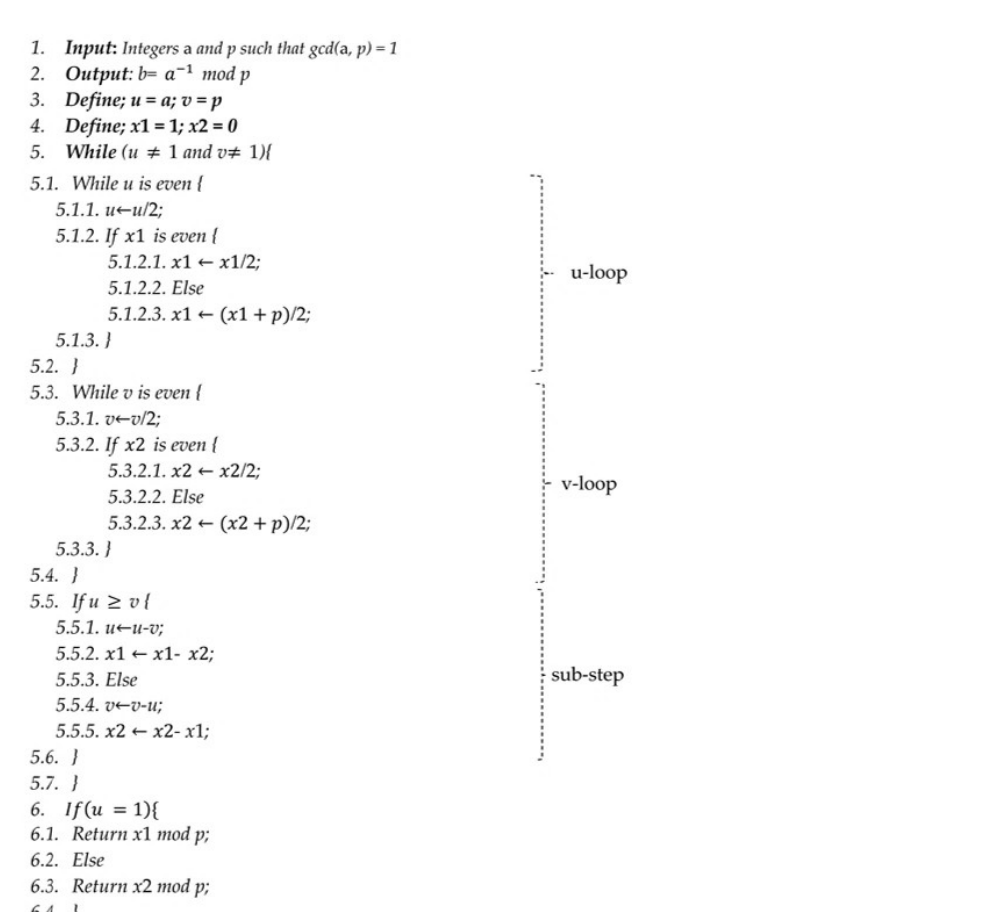
Algorithm 1: Pseudo-code of the BEE